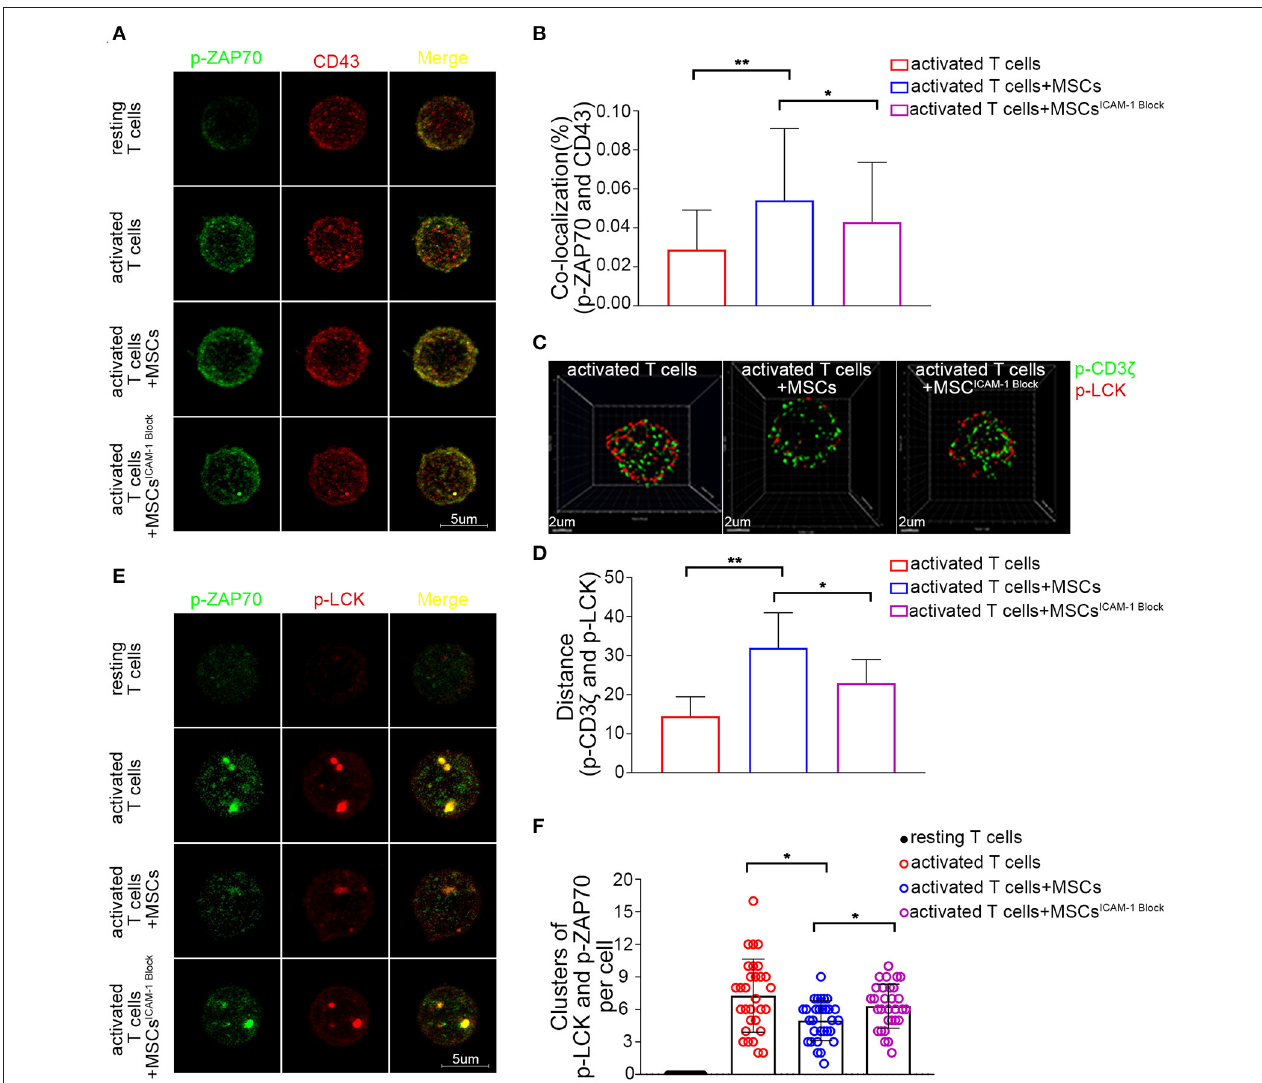
FIGURE 6 | CD43-mediated TCR microcluster formation in activated T cells is rapidly altered by MSCs coculture through MSCs-derived ICAM-1. (A) Resting and activated T cells were plated on poly-lysine coated plates, and then fixed and stained for p-Zap70 (Y319) (green) and CD43 (red). Confocal images were collected. Far right shows overlay images. Four groups were analyzed: resting T cells, activated T cells, activated T cells cocultured with MSCs and activated T cells cocultured with ICAM-1-blocked MSCs. (B) The colocalization percentage of p-ZAP70 and CD43 in activated T cells, activated T cells cocultured with MSCs and activated T cells cocultured with ICAM-1-blocked MSCs. (C) Analog images display the distribution of p-CD3 ζ (green) and p-LCK (red) in activated T cells. Three groups were analyzed: activated T cells, activated T cells cocultured with MSCs and activated T cells cocultured with ICAM-1-blocked MSCs. (D) Column shows the distances between p-CD3 ζ and p-LCK in activated T cells of groups described in (C) . (E) Images show the distribution of microclusters of p-LCK (red) and p-ZAP70 (green) in resting and activated T cells, activated T cells cocultured with MSCs, and activated T cells cocultured with ICAM-1-blocked MSCs. Far right shows overlay images. (F) Numbers of formed p-ZAP70-containing microclusters per cell. Data are shown for the groups described in (E) . The data presented are representative of a minimum of three separate experiments. Panels are representative of at least 20 cells each. Significant differences are indicated as follows: * p < 0.05 and ** p <